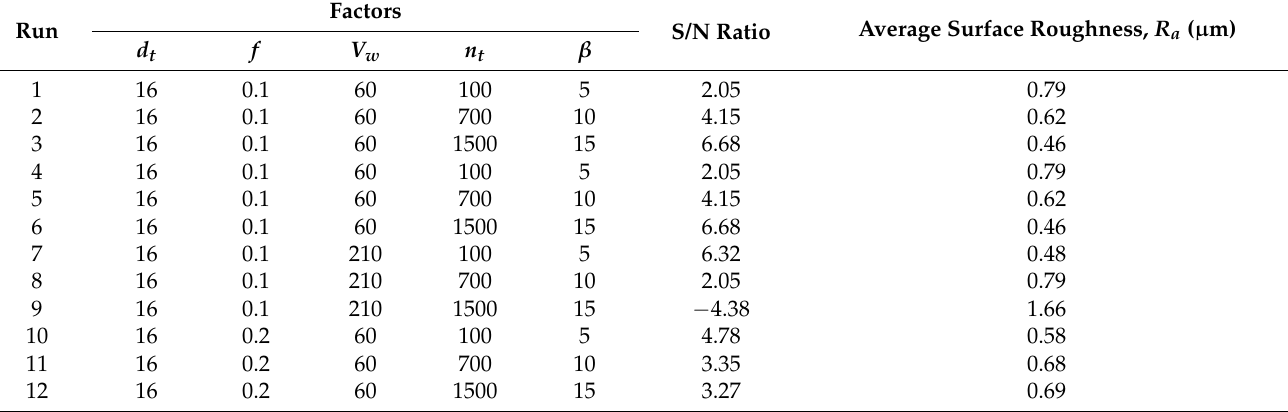
Table 3. Taguchi experimental design with orthogonal array L36 (2 3 × 3 2 ) and experimental